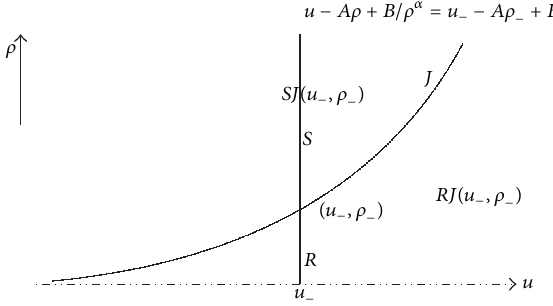
Figure 2: Phase plane and elementary wave